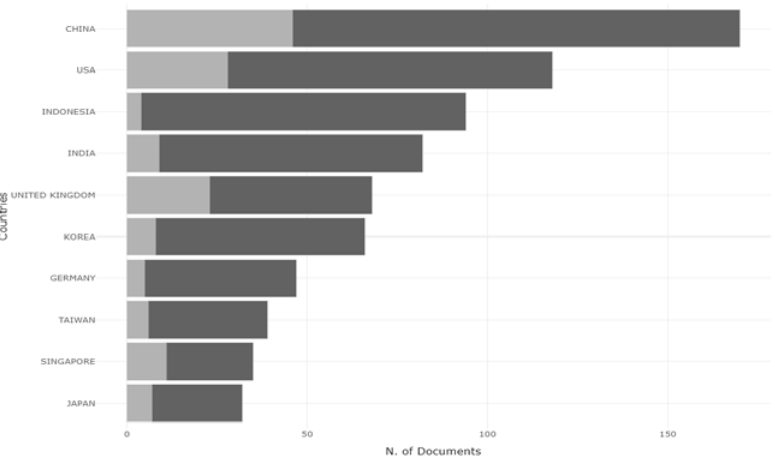
Figure 5. Corresponding author